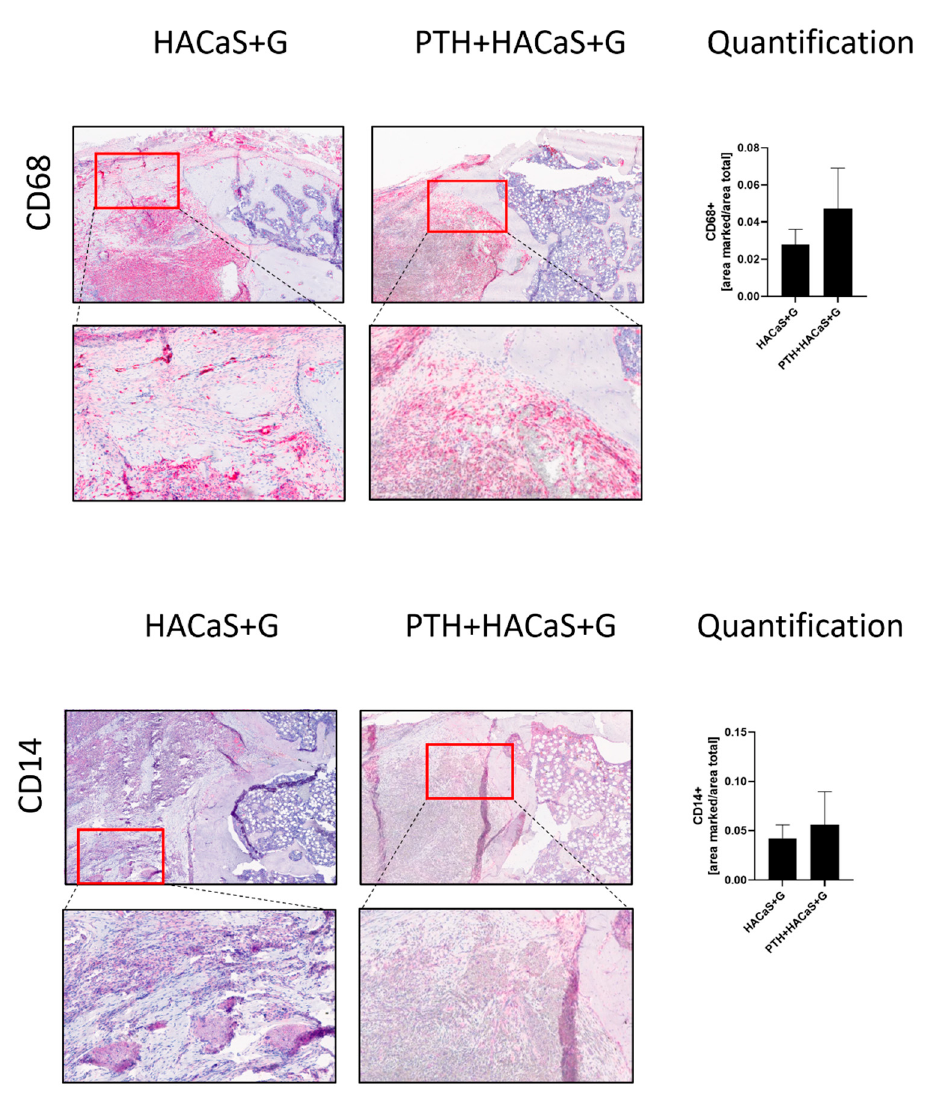
Figure 7. CD14 and CD68 staining, markers for tissue macrophages. This is a comparison of the outer edge of the defect gap between the HACaS+G- and the PTH+HACaS+G-treated groups. Some of the remaining boney ends can be observed towards the right side of the image. The endothelial cell marker CD31 was used to quantify vascularization in the